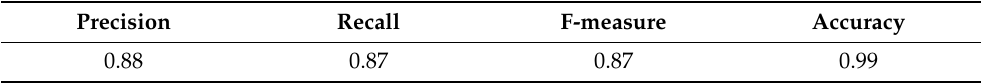
Table 1. Analysis of the picked horizons in Figure